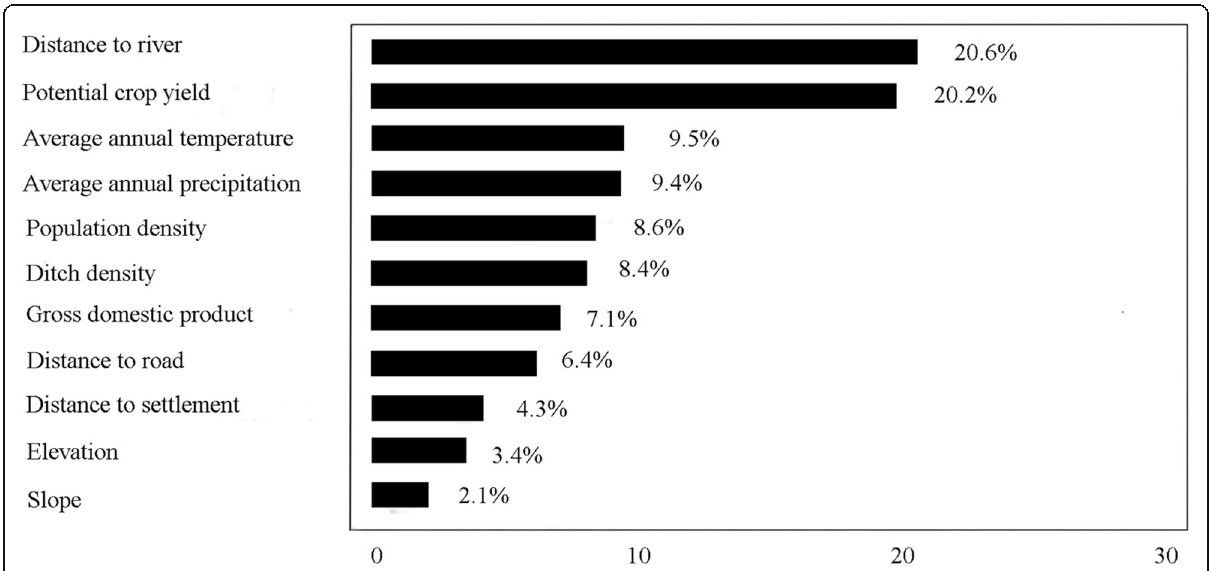
Fig. 7 Relative important of explanatory variable for the